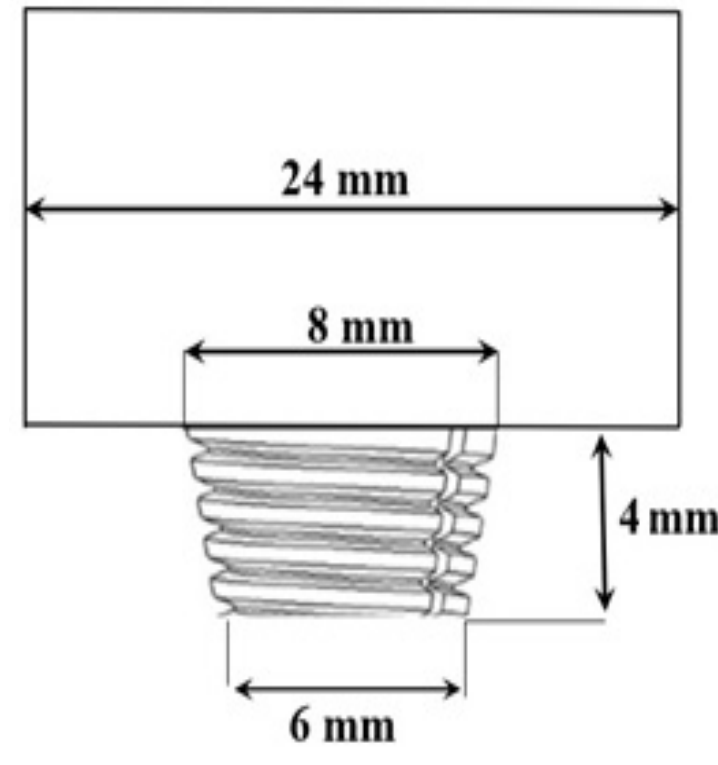
Figure 2. Schematic diagram of FSW tool used for FSAM .